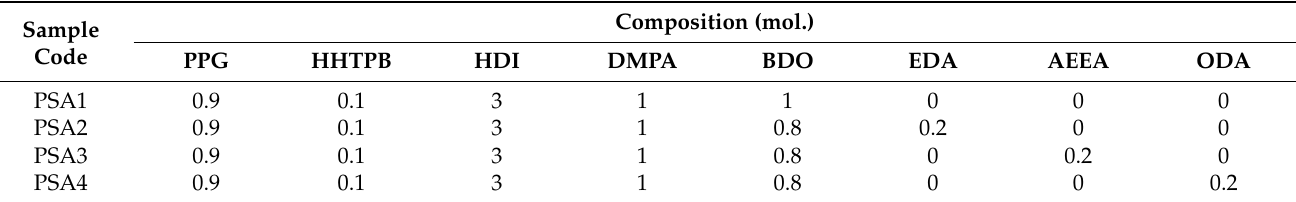
Figure 2. Schematic synthesis of waterborne polyurethane pressure sensitive adhesives (WPU-PSAs). Table 1. Composition for the syntheses of WPU-PSAs.